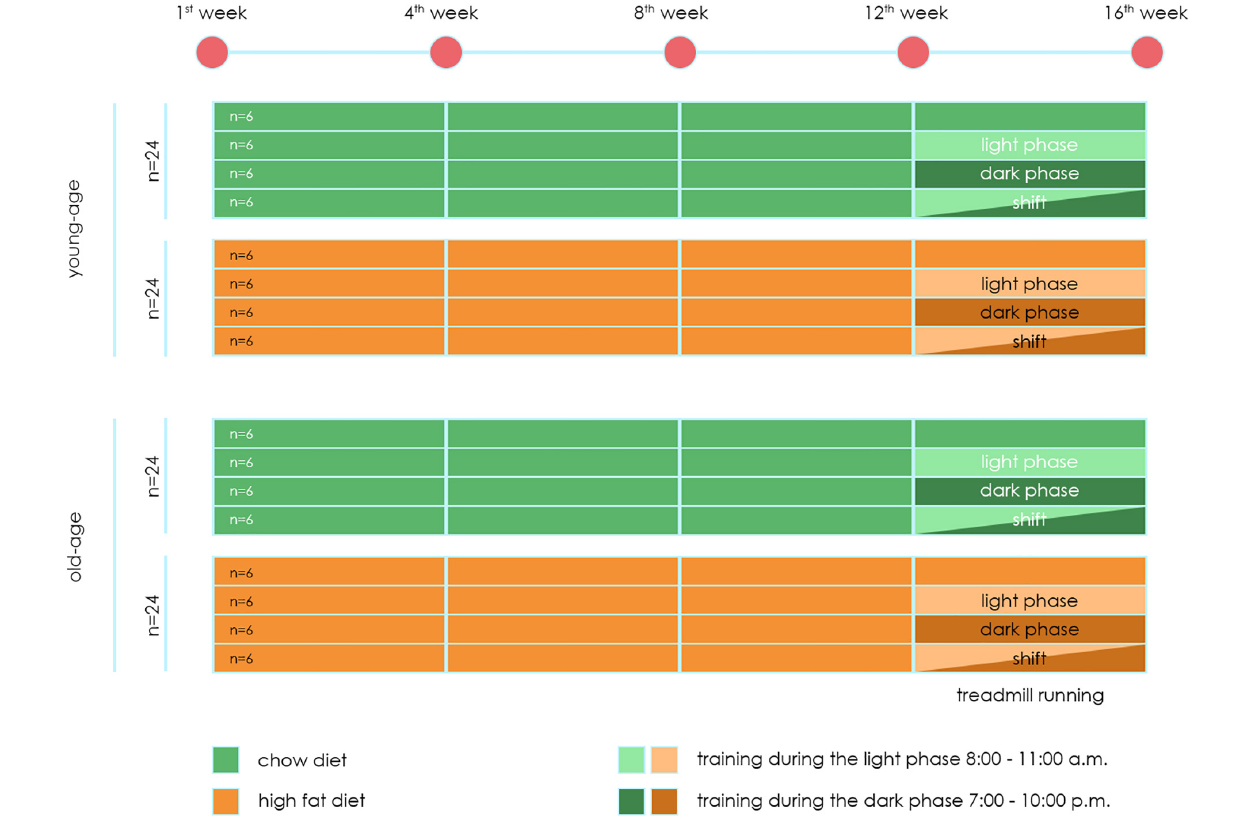
FIGURE 1 | Experiment